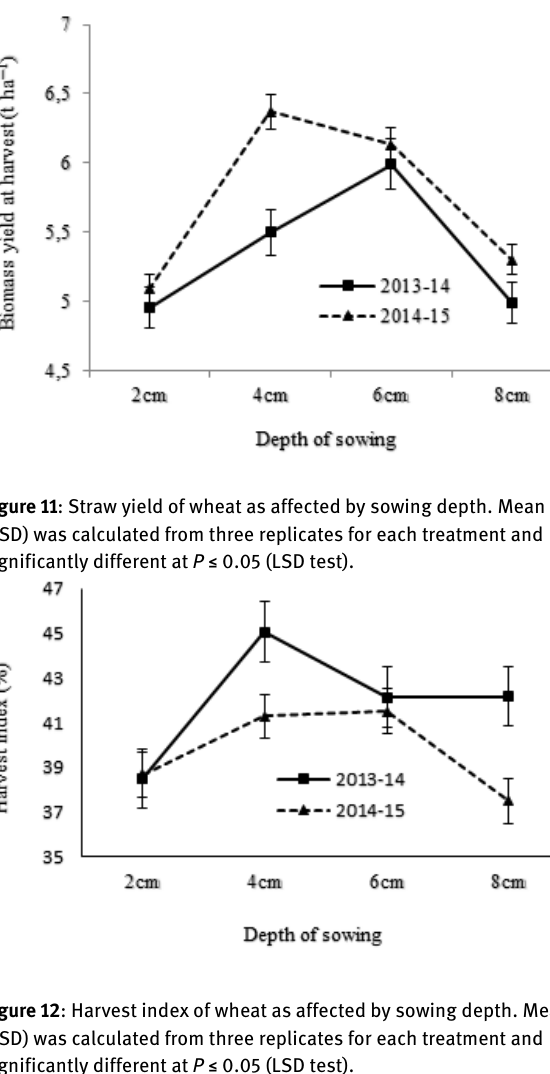
Figure 12 : Harvest index of wheat as affected by sowing depth. Mean (±SD) was calculated from three replicates for each treatment and significantly different at P ≤ 0.05 (LSD